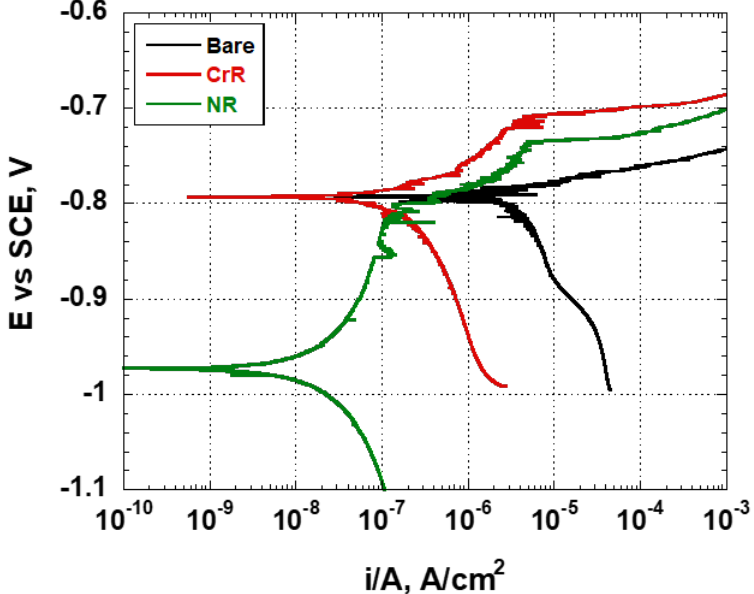
Figure 4. Experimental set-up used for electrochemical characterisation of samples.